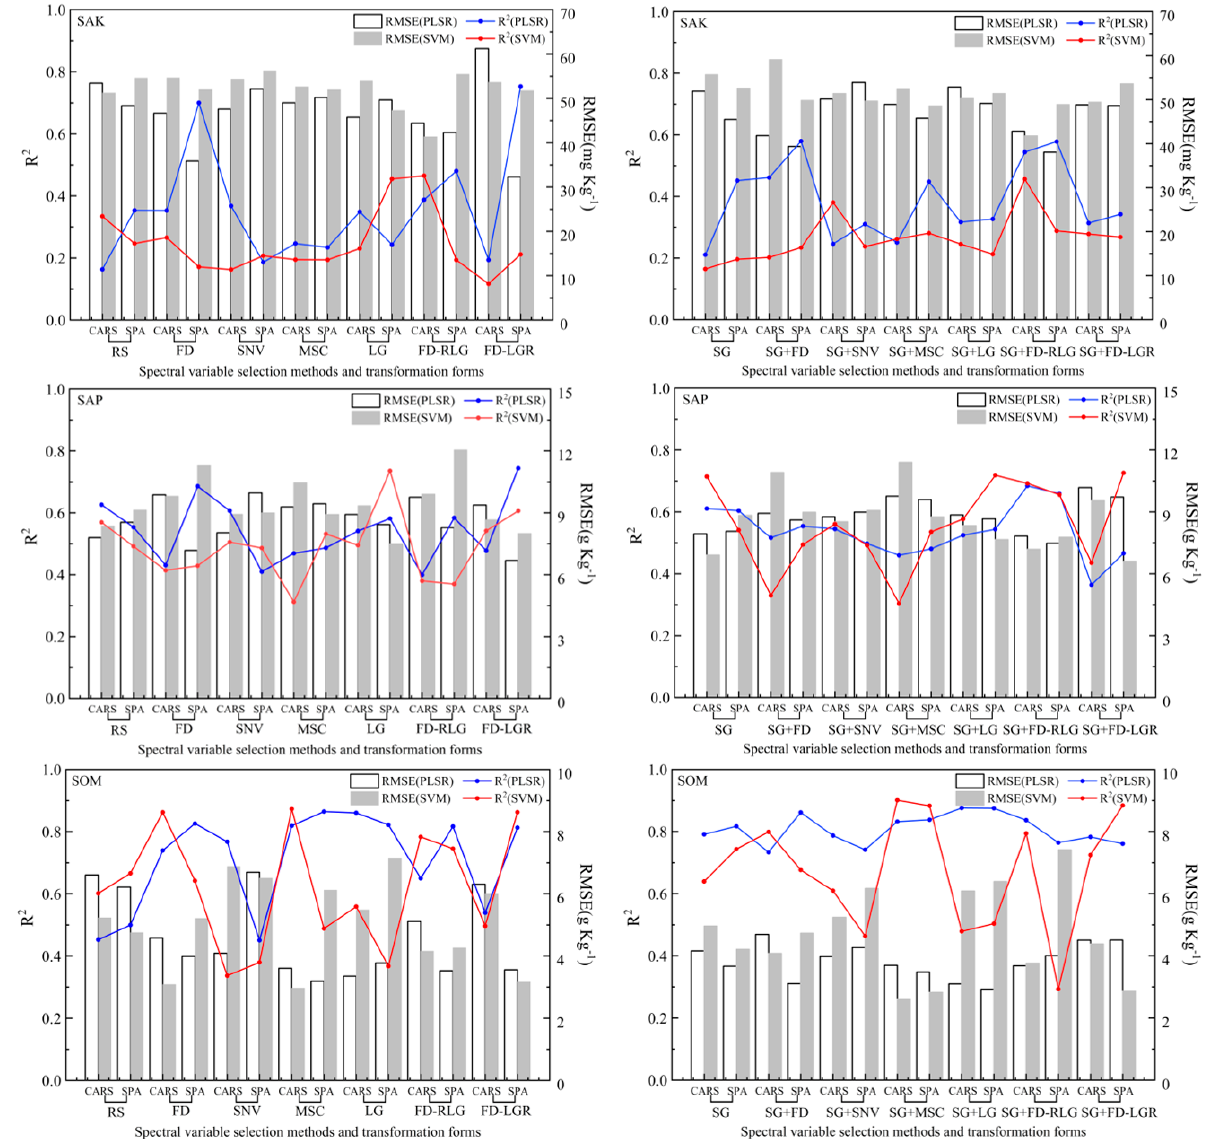
Figure 7. Independent prediction results for three soil nutrient (SAK, SAP, and SOM) estimations under different spectra pre-processing transformation methods and spectral variable selection methods.